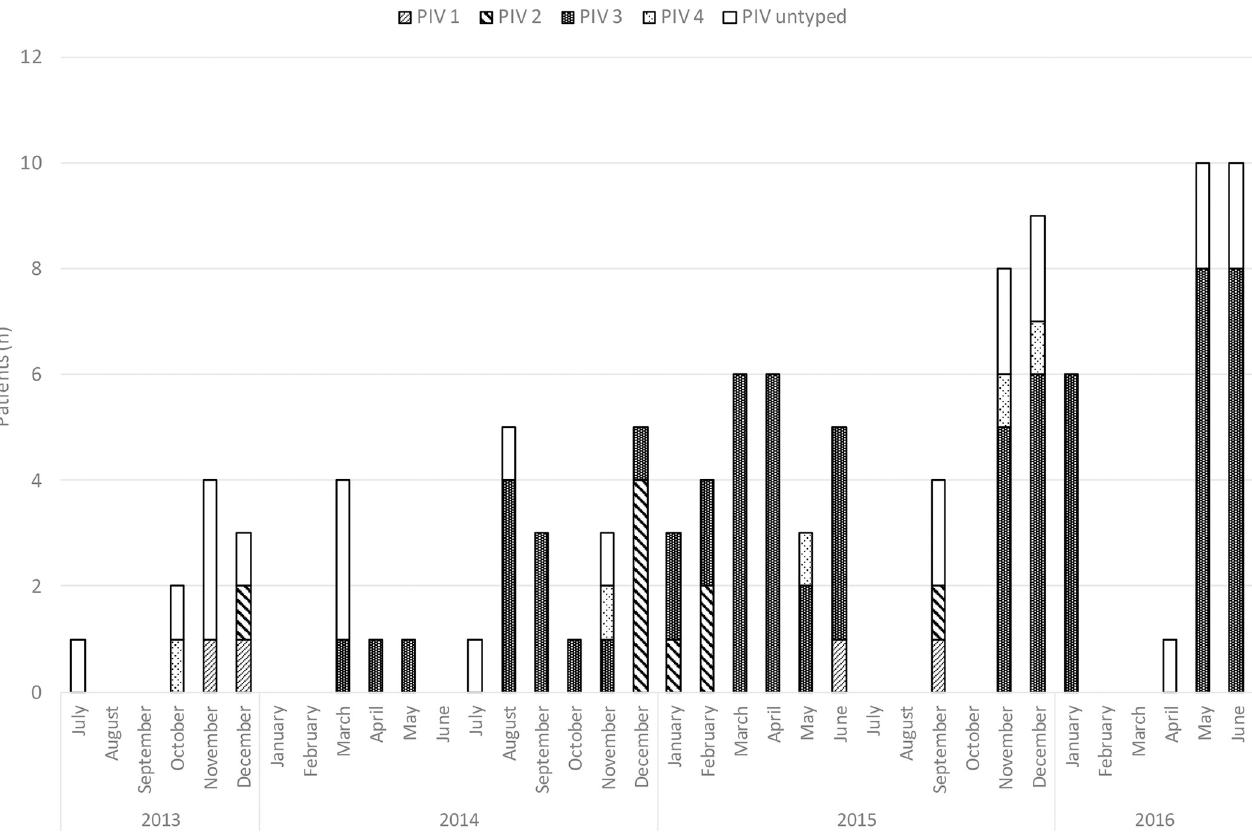
Fig 1. Timeline of parainfluenza virus infections. Untyped PIV: Samples were PCR positive, but could not be sequenced for further typing due to low viral loads.